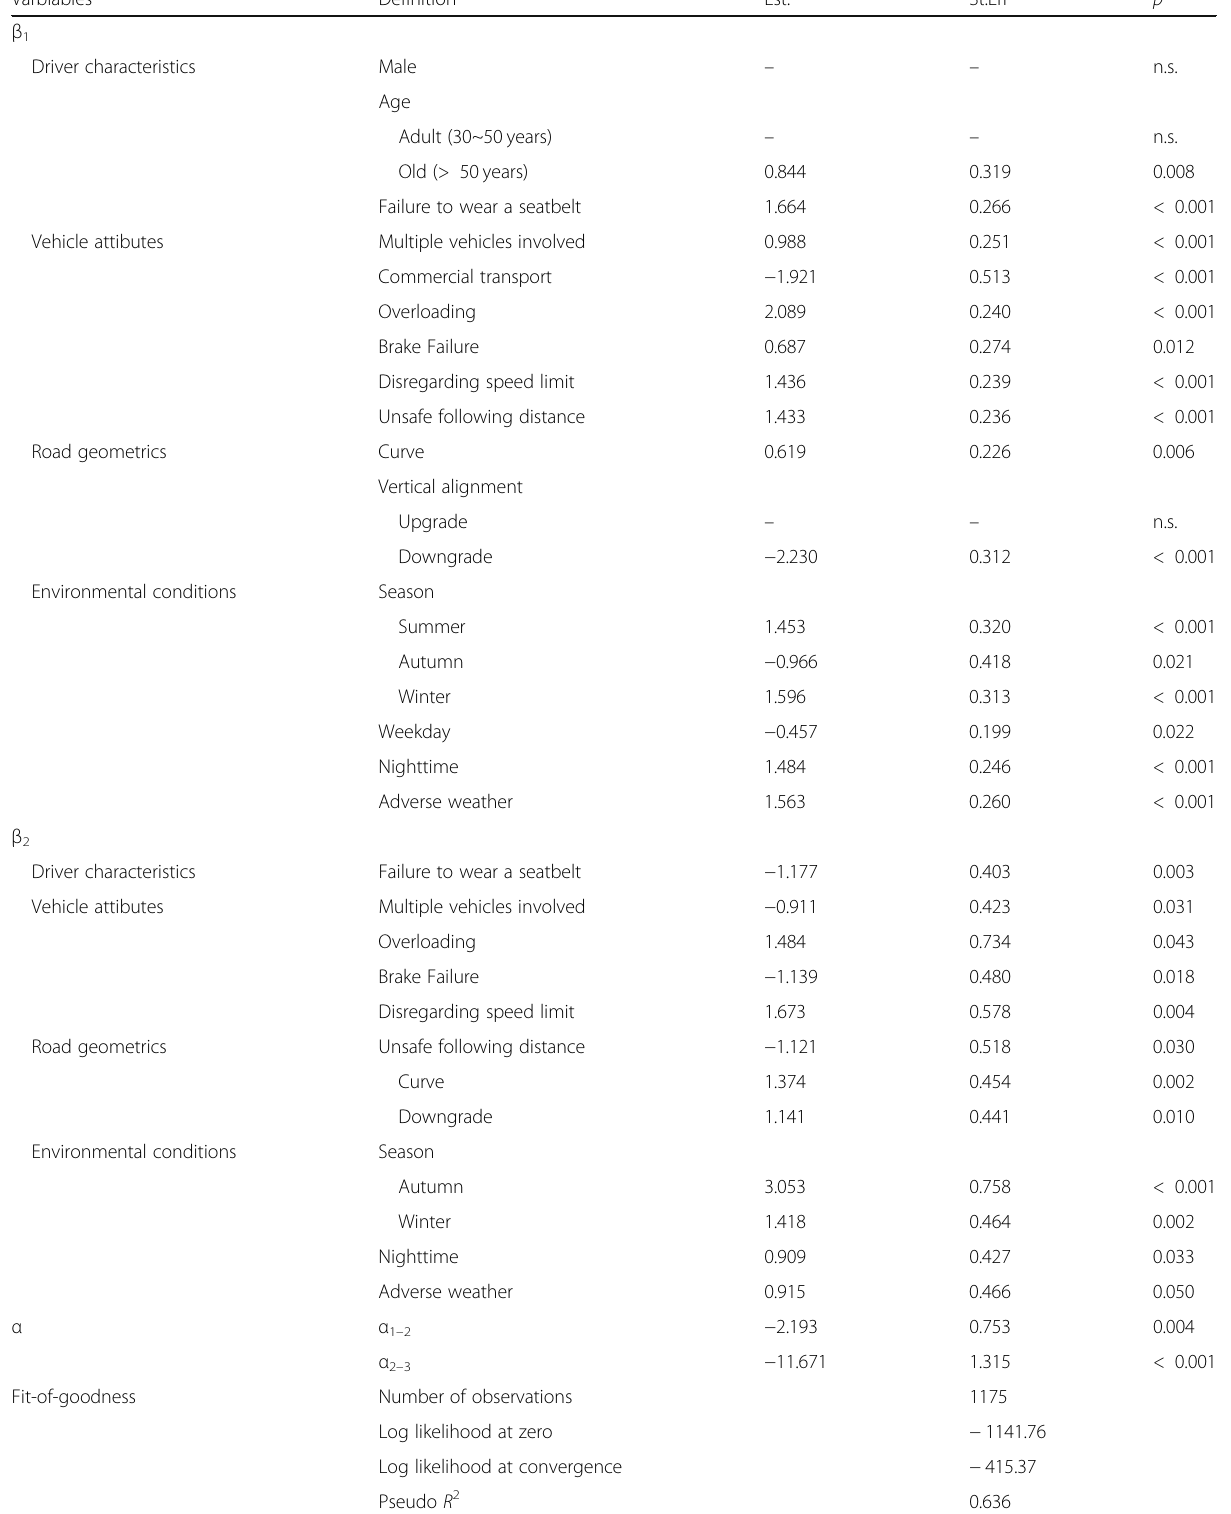
Table 2 Estimation results for the partial proportional odds